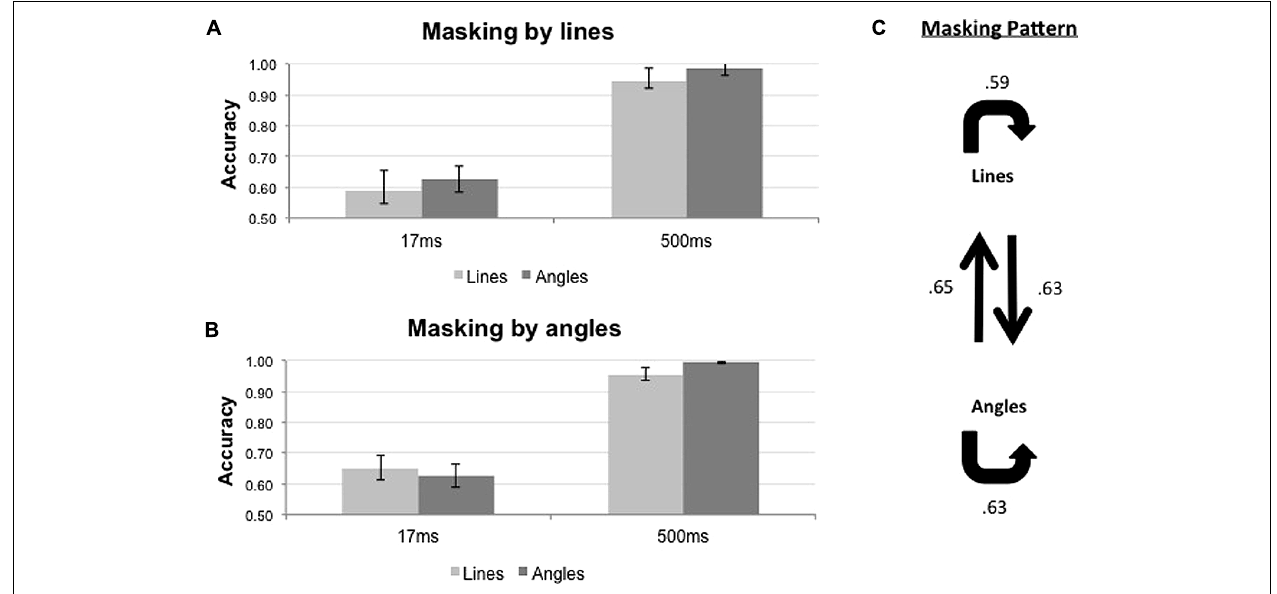
FIGURE 5 | Proportion of correct responses ( n = 8) when lines (light gray bars) or angles (dark gray bars) were masked by (A) lines or (B) angles, across two ISI settings (17 and 500 ms). (C) Masking pattern between lines and angles. Conventions as in Figure 4 . Table 2 | Repeated MeasuresANOVA and post hoc pairwise comparisons for Experiment 2 ( n = 8 ). ANOVA P Partial η 2 Post hoc pairwise comparison,